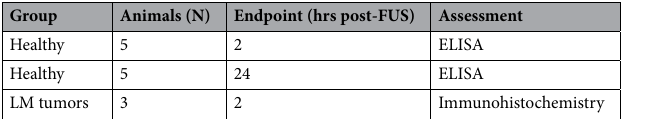
Table 1. Distribution of